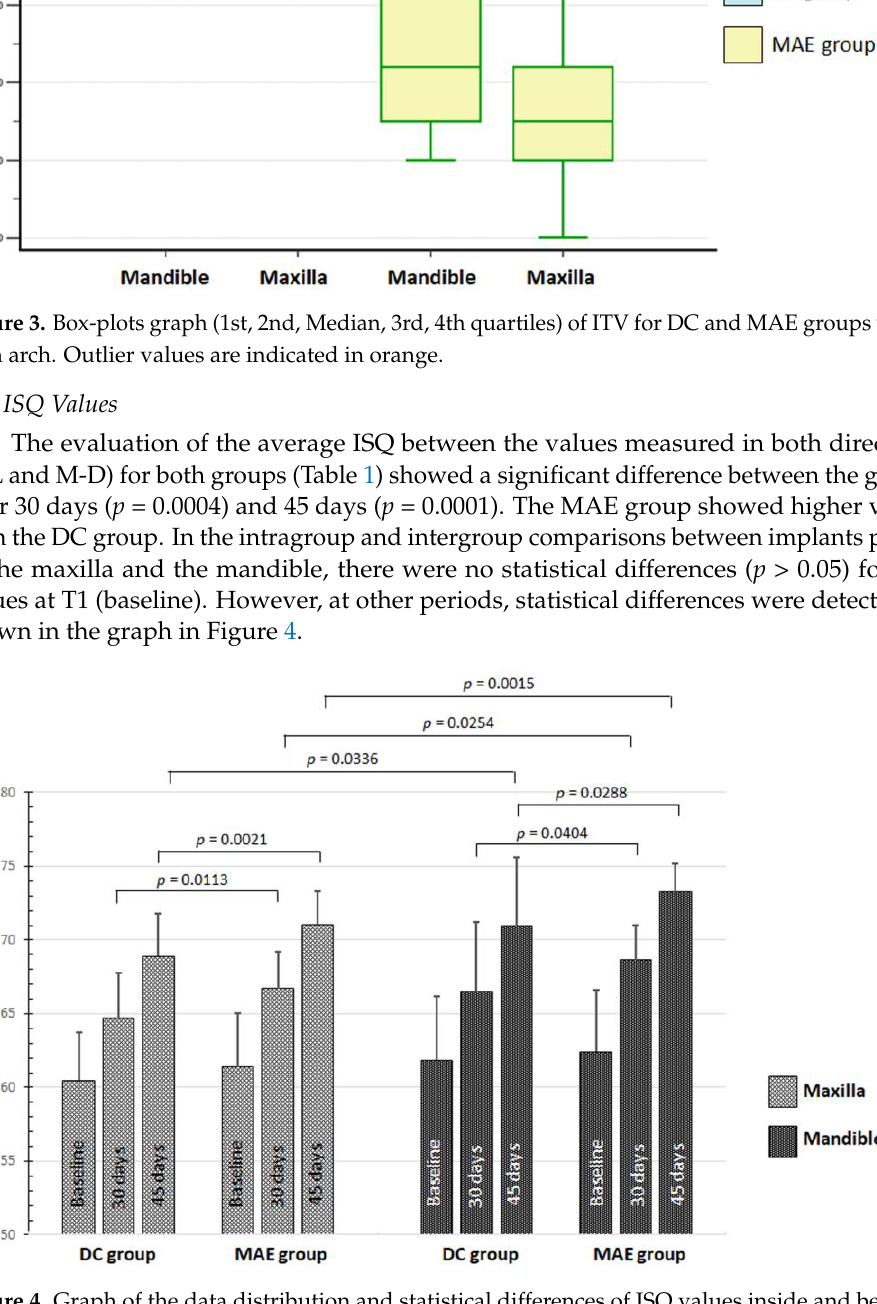
Figure 4. Graph of the data distribution and statistical differences of ISQ values inside and between both groups in maxilla and mandible on the 3